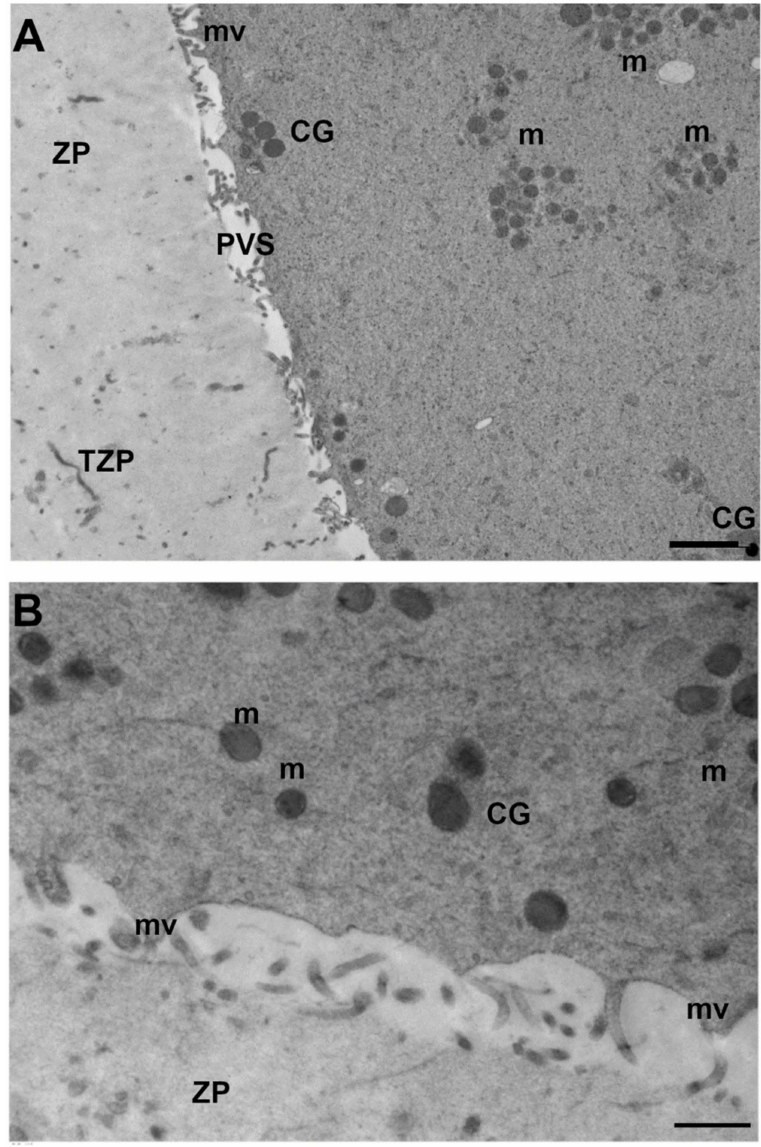
Figure 2. Representative unpublished archived TEM micrographs of GV-stage human oocytes from stimulated ovaries [22,29,30] showing in ( A ) the cortex with a pale and spongy zona pellucida (ZP) crossed by numerous residues of transzonal projections (TZP) and a thinner perivitelline space (PVS) in which numerous thin microvilli (mv) protruding from the oolemma are visible. The ooplasm is characterized by the rare presence of suboolemmal cortical granules (CG) and numerous mitochondria (m), which are often present in clusters in the inner ooplasm. TEM, bar: 1 µ m; ( B ) higher magnification of the cortical ooplasm with round-to-ovoid mitochondria (m), slightly electron-dense cristae and rare cortical granules (CG). The oolemma is folded in numerous microvilli (mv) protruding in the perivitelline space. ZP: zona pellucida. TEM, bar: 800